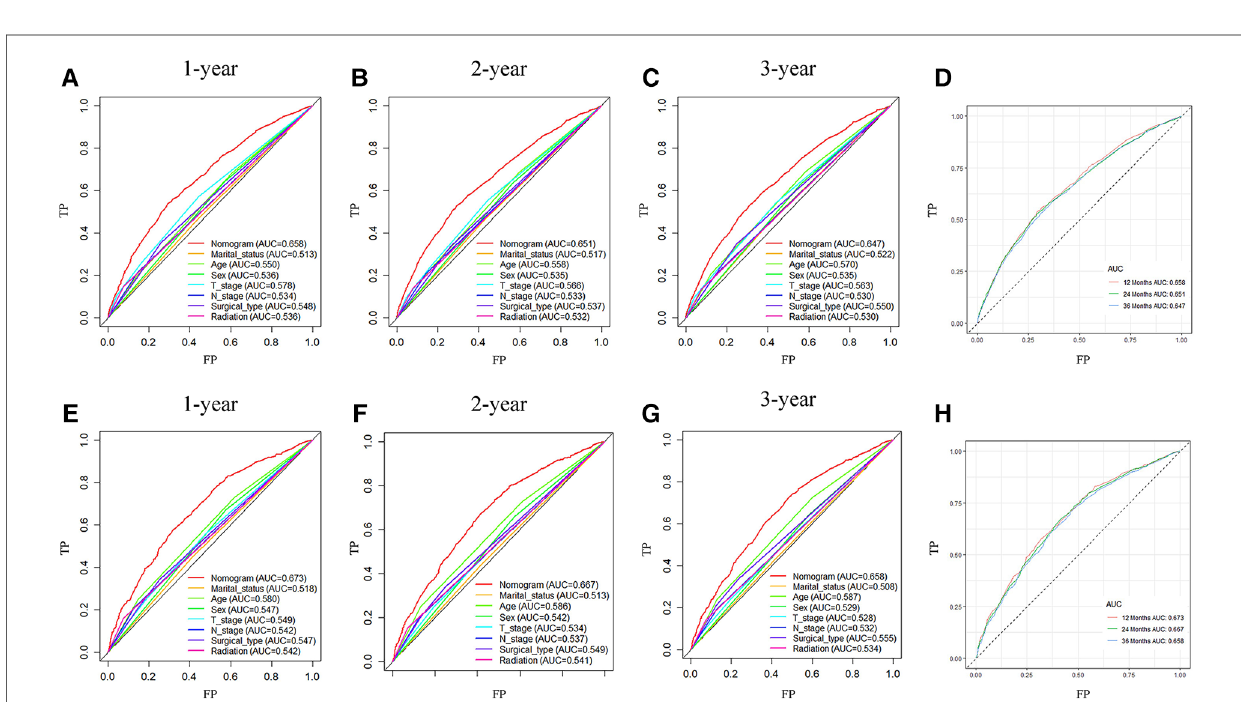
FIGURE 2 ROC curves of nomogram prediction of prognoses in training and validation cohort patients. ( A – D ) ROC curve for 1-, 2- and 3-year timepoints in the training cohort. ( E – H ) ROC curve for 1-, 2- and 3-year timepoints in the validation cohort. ROC, receiver operating characteristic curve; AUC, area under the ROC curve; TP, true positive rate; FP, false positive